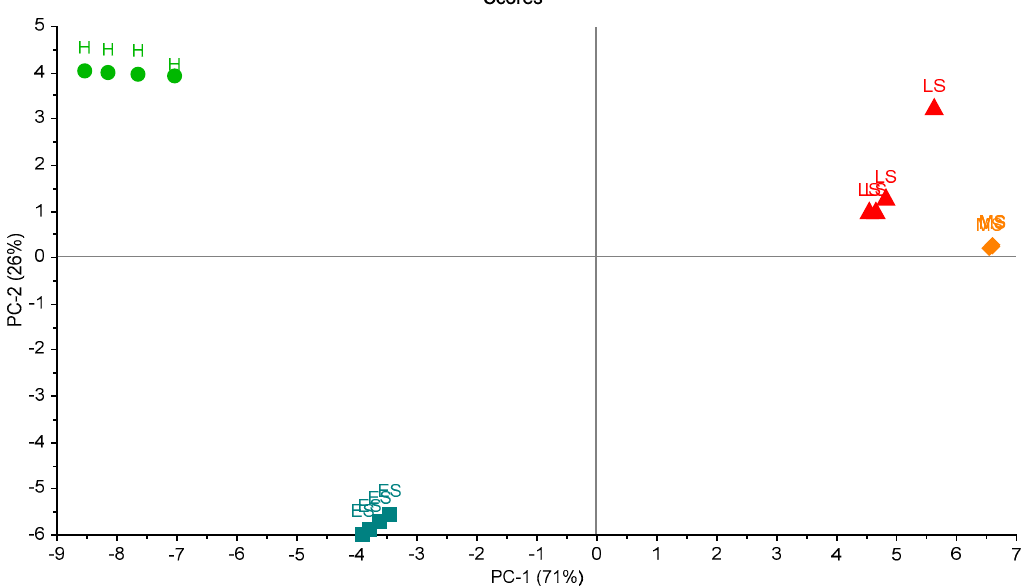
Figure 8. Scores plot of the samples in the second trial of measurements. A clear separation between samples is shown. Healthy sample (H), infected early-stage (ES), infected moderate-stage (MS), and infected late-stage (LS).